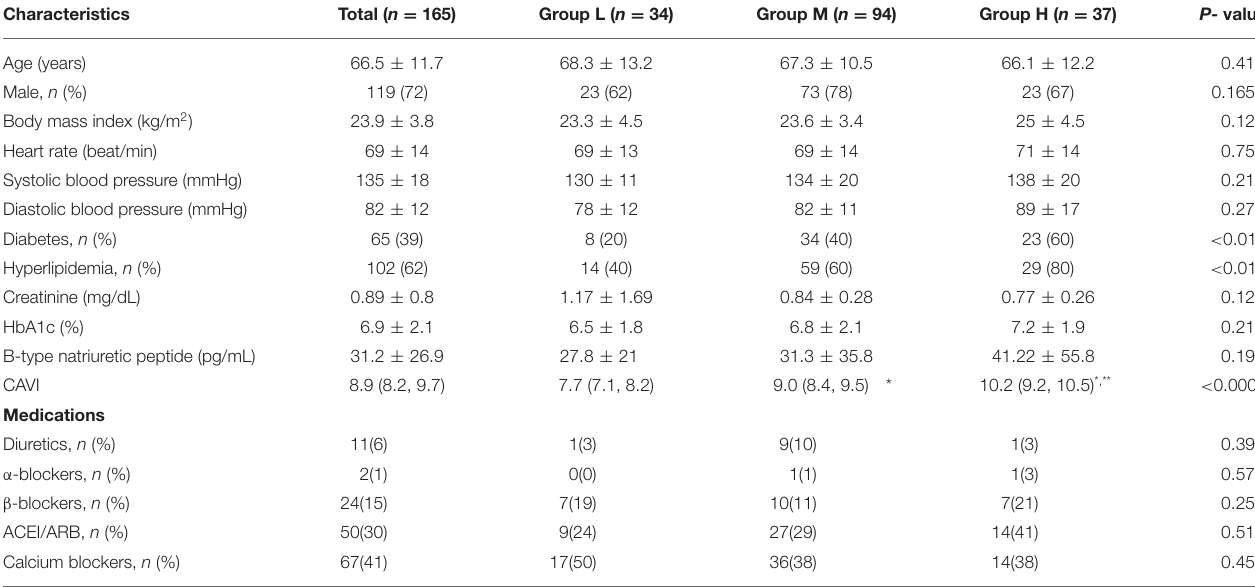
TABLE 1 | Comparison of the clinical characteristics of the study subjects among the study groups.